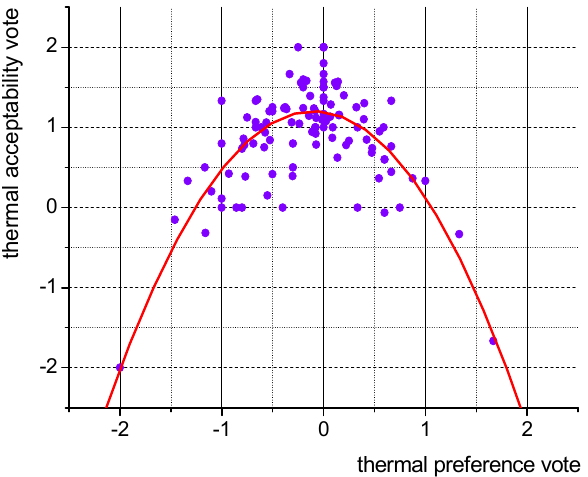
Figure 15. Thermal acceptability vote vs. thermal preference vote—data for all the buildings, the red line represents the approximation curve, while the purple dots the average values of TAV.